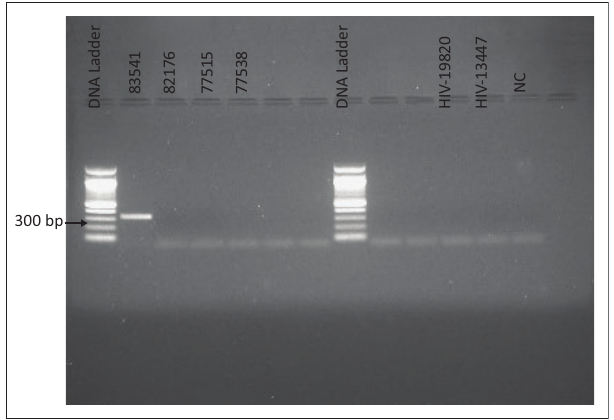
FIGURE 2: Gel Electrophoresis with a 100 bp DNA ladder. Specimens 83541, 82176, 77515 and 77538 are known HIV-2 antibody positive. Specimen 83541 tested positive for HIV-2 PCR (fragment size = 338 bp). HIV-1 specimens (9820 and 3447) with high viral load were